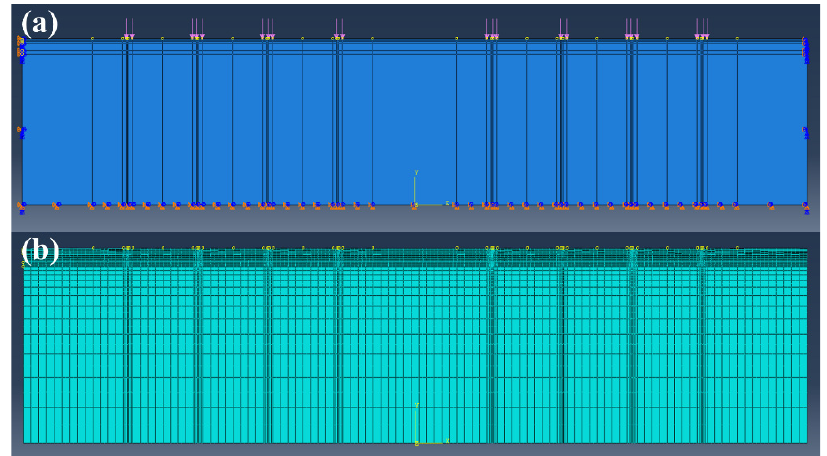
Figure 2. Pavement modeling in ABAQUS: ( a ) loads and boundary conditions; ( b ) meshes.